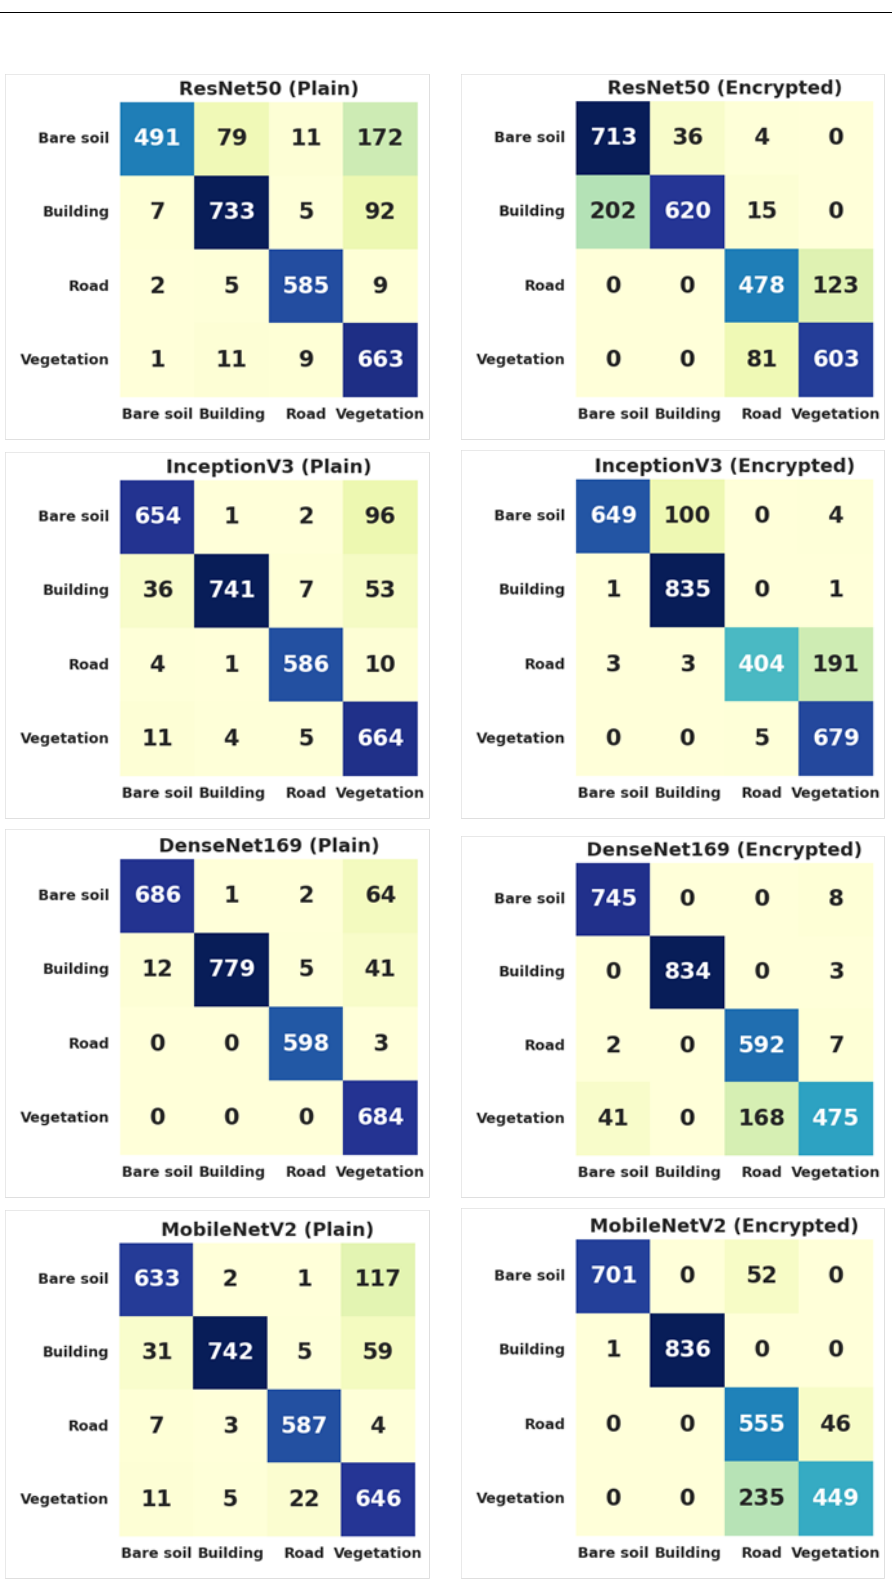
Figure 10. Confusion matrices obtained for the 4 different CNN architectures (from top to bottom : ResNet50, InceptionV3, DenseNet169, MobileNetV2), on the validation set, for both the plain ( left ) and encrypted ( right )